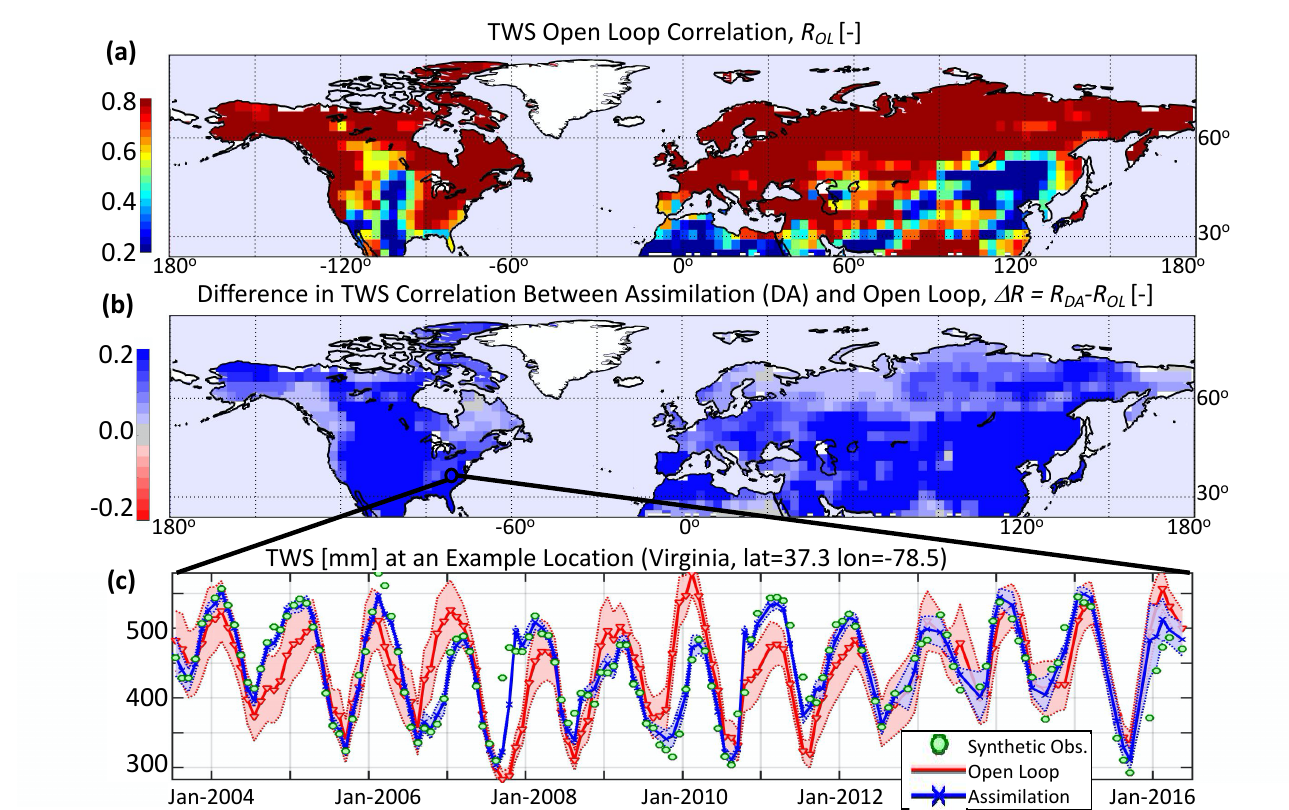
Figure 3. ( a ) Correlation coefficient between open-loop (OL) estimates and synthetic observations of Terrestrial Water Storage (TWS). ( b ) Difference in correlation ( ∆ R ) between the data assimilation (DA) and OL TWS. Statistics are computed using 156 monthly estimates. TWS estimates from the OL and DA runs are temporally and spatially averaged and resampled to match the resolution of the synthetic observations. ( c ) Example TWS observations (green circles) and TWS from the open-loop (red lines) and assimilation (blue lines) experiments for a location in Virginia, United States (37.32 N, 78.46 W). Shaded areas illustrate the ensemble spread ( ± one ensemble standard deviation from the ensemble mean) for the open-loop (red shading) and assimilation (blue shading)